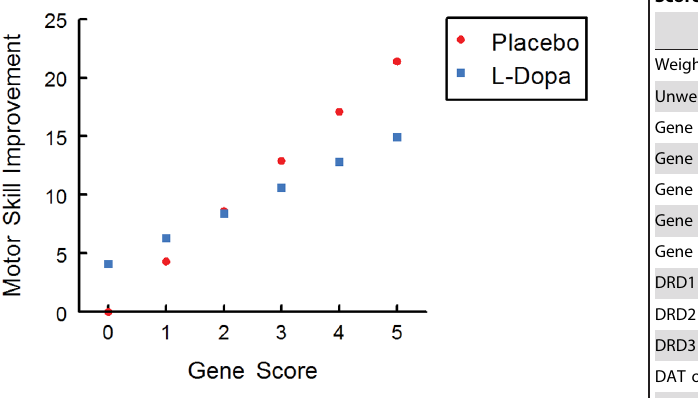
Figure 4. Effect of L-Dopa on skilled motor learning varied with gene score. Below gene score=2, L-Dopa provides better learning, and above gene score=2, Placebo provides better learning. Values are derived from the mixed-effects model and reflect the percent improvement from the reference condition of gene score=0 during the placebo week, using the average value for all covariates.